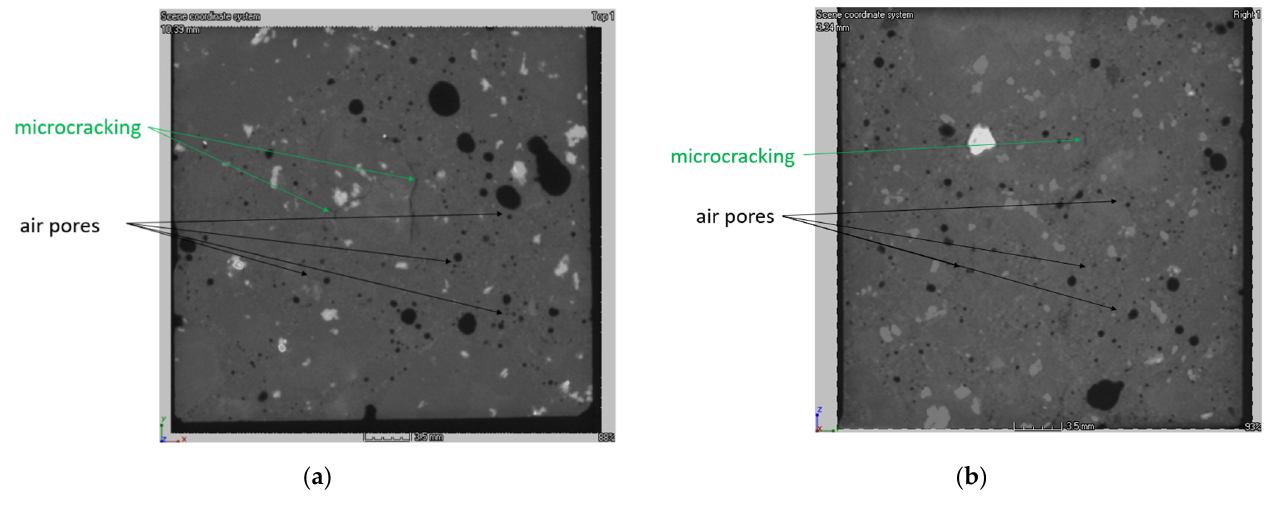
Figure 25. This is a figure. Schemes follow another format. If there are multiple panels, they should be listed as: The internal structure of concrete series CC-1 ( a ) and series CC-2 ( b ). Table 11. Concrete characteristics as specified in TEM.